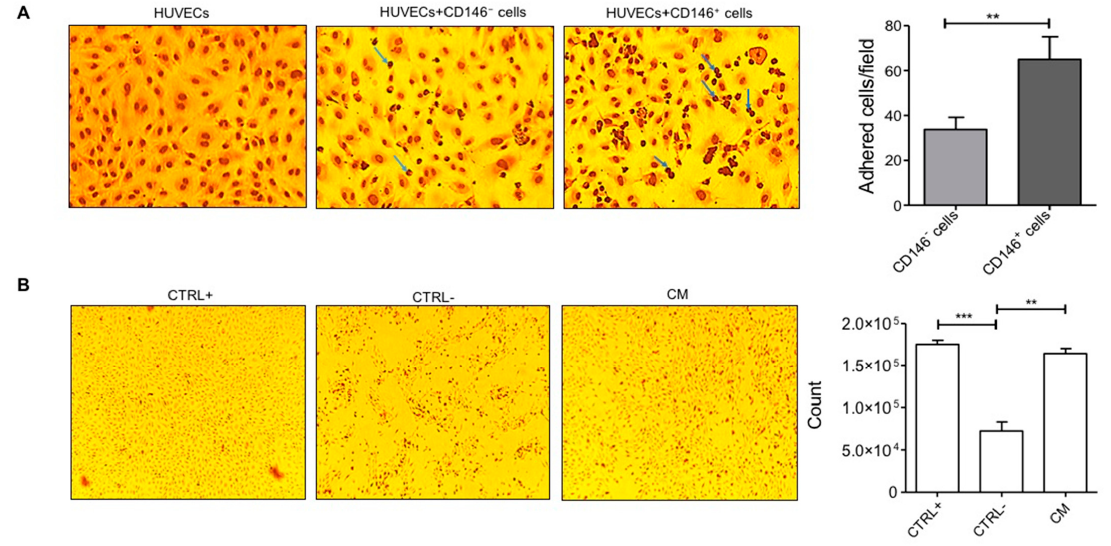
Figure 3. ECs ‐ PCs interaction ( A ) Adhesion assay. PCs detached from tissue culture flasks were seeded on a cultured ECs monolayer. In the figure, adherent PCs appear as darker round cells (for example, indicated by blue arrows) adhered to the elliptical ‐ shaped HUVECs monolayer. CD146 + cells were relatively more adherent than CD146 cells to ECs. Images are representative of three different experiments performed in triplicates. The left corner image represents the HUVECs mon ‐ olayer as a negative control in the absence of adhered pericytes. The bar graph displays the number of adhered cells per frame (counted for three different frames/well) performed in triplicates at 10× magnification. ( B ) Cell proliferation assay. Cells cultured under starvation conditions proliferated in the presence of CM from MFAT (diluted 2 ‐ fold in RPMI medium). Images were taken after 16 h of treatment at 4× magnification. ECs cultured in the complete medium (EGM + 10% FBS) were used as a positive control. ECs cultured under starvation conditions (EBM + 0.5% FBS; NC) were used as a negative control. The bar graph shows the cell count after overnight treatment with CM. Images are representative of one out of three independent experiments with similar results performed in triplicates. Statistical analysis was performed by Student’s t ‐ test and one way ANOVA following Bonferroni’s post ‐ test; ** p < 0.01, *** p < 0.001. CM—conditioned medium. 2.4. Micro Fragmented Adipose Tissue (MFAT) ‐ Derived CD146 + PCs Subset Promotes Vascular Stability We initially investigated if the conditioned medium (CM), obtained by incubation of the whole PCs population derived from MFAT tissue and cultured at very low serum concentration in basal medium, was able to preserve ECs vascular monolayer integrity. Thus PCs ‐ CM was added (2 ‐ fold diluted) to the HUVECs monolayer and then cultured under starvation for 24 h. PCs ‐ CM demonstrated potent efficacy in preserving ECs mon ‐ olayer integrity. The effect of CM was equal to that of the complete growth medium (EGM + 10% FBS). In contrast, the EC monolayer cultured under starved conditions (medium consisting of only EBM + 0.5% FBS) and in the absence of PCs ‐ CM was significantly dam ‐ aged: cells were non ‐ viable and almost completely detached as observed by the presence of floating cells in the culture (Figure 3B). Furthermore, ECs stimulated with PCs ‐ CM up to a dilution of 64 ‐ fold were able to survive under starved conditions (Figure S5). Once the efficacy of PCs on vascular monolayer integrity was established, we next performed a 3 ‐ D spheroids assay by mixing CD31 − PCs and ECs in a ratio of 1:5. As shown in Figure 4A, the presence of PCs not only perturbated the angiogenesis process but also aggravated the same as observed by a higher number of sprouts formed by HUVECs. This strong effect was also confirmed by CD31 + endothelial cells derived from the fat tissue